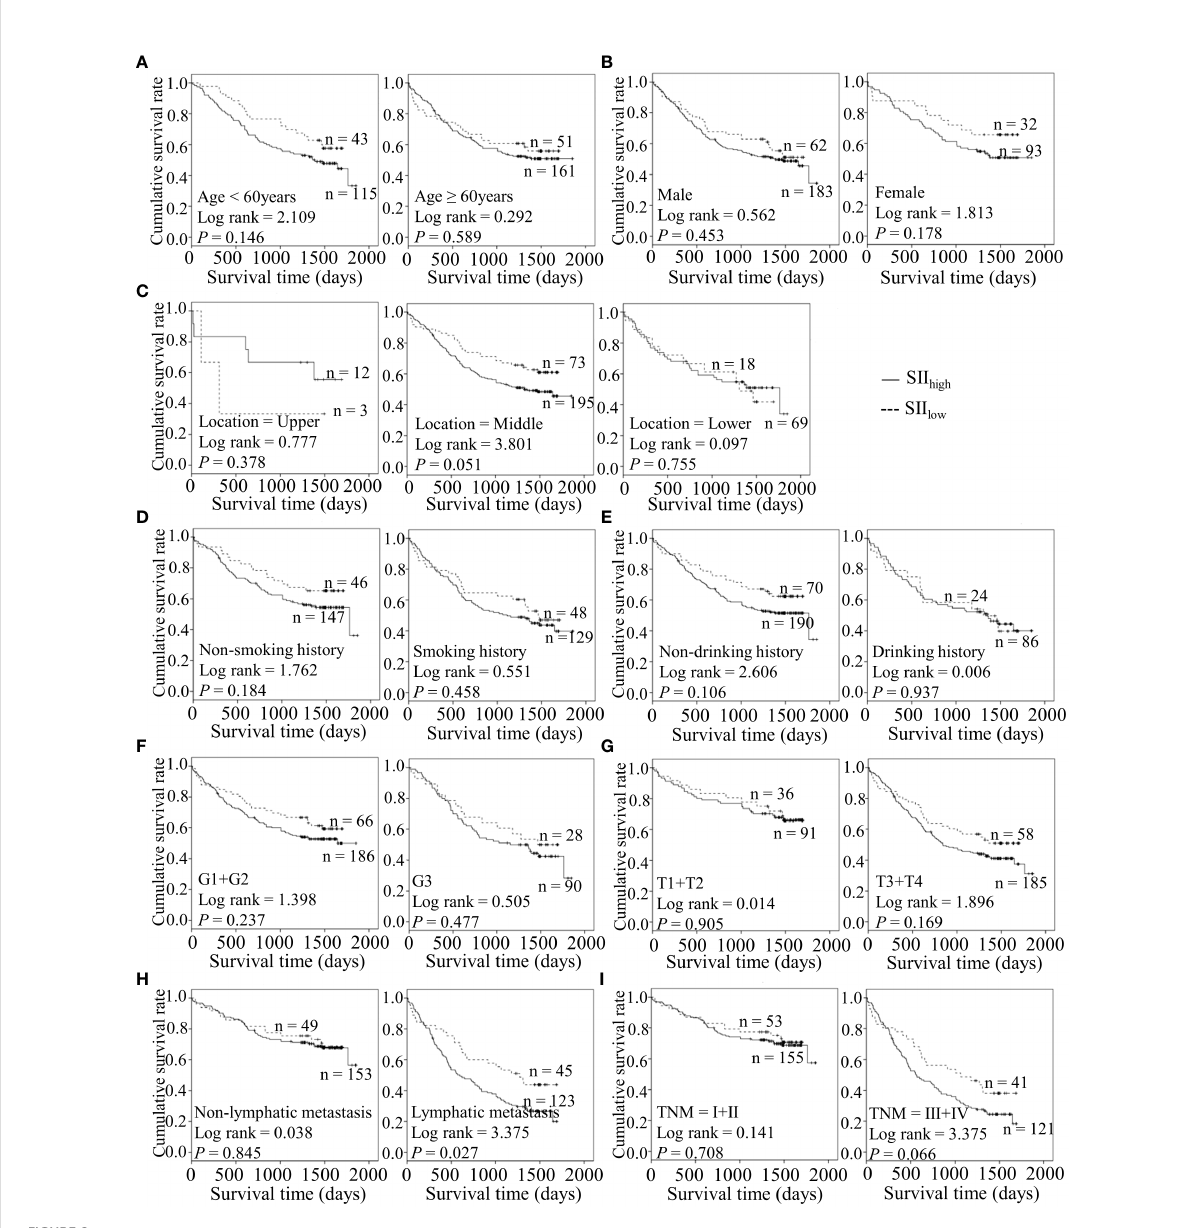
2.43 – 30.551, P = 0.001) and LMR ( HR = 0.504, 95% CI = 0.331 – 0.768, P = 0.001) were identi fi ed as an independent predictors of adverse events in ESCC (Table 3). Importantly, T stage and TNM staging appear to be risk factors and preoperative LMR plays a protective role in survival outcomes of ESCC patients subjected to surgery. Our fi ndings support the utility of LMR as a superior predictor of ESCC survival outcomes.